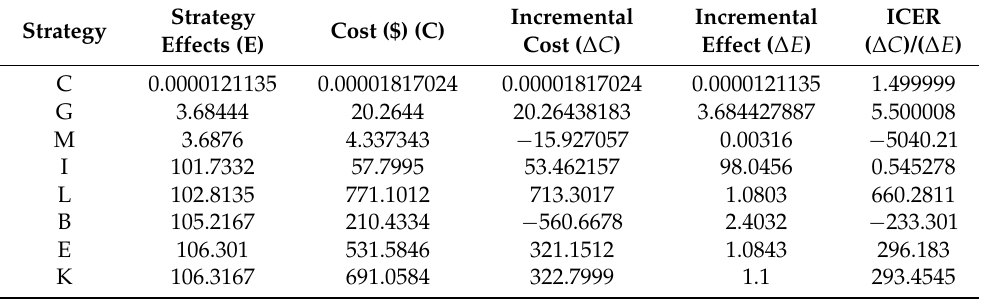
Table 8. Exclusion of more costly and less effective intervention strategies for Endemic region.